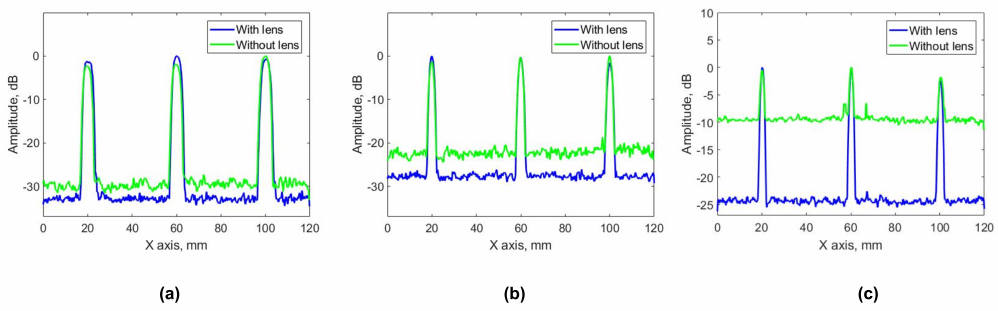
Figure 10. Lateral profile of results obtained for block ( a ) A, ( b ) B, and ( c ) C on the X-axis. Taking the average values of the noise background for each block, the improvement of SNR can be obtained for each case by comparing it with and without PR-FZP. SNR improvement obtained for each case is 3, 6 and 15 dB for blocks A, B, and C,